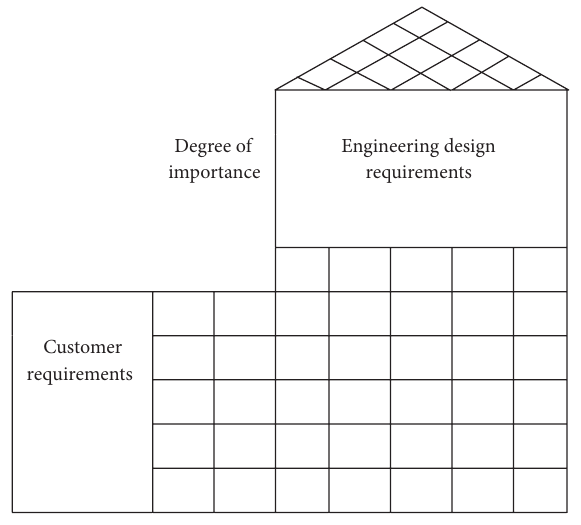
Figure 1: QFD relationship